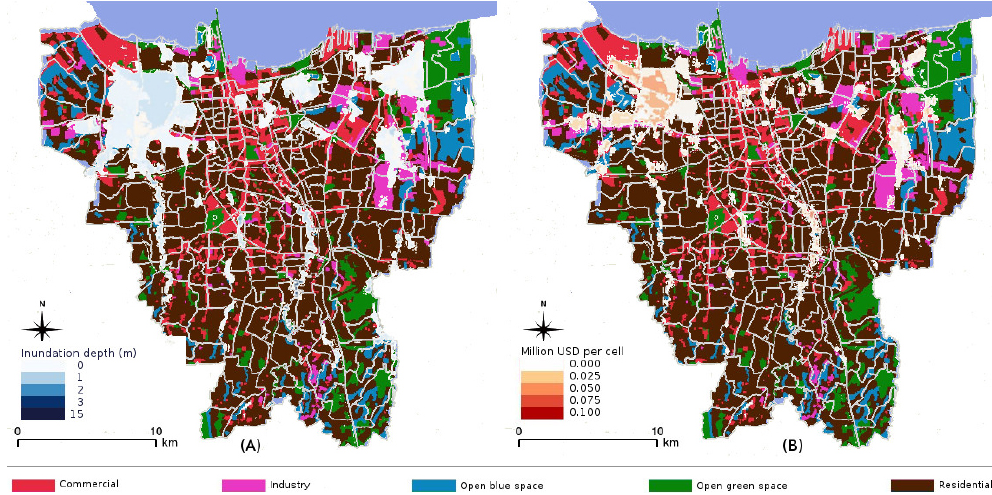
Figure 3. Flood hazard map for a return period of 100 years in current conditions (a) ; and annual expected damage (b) . The background is land use map 2009, reclassed into five land use classes found in the three previous land use maps.